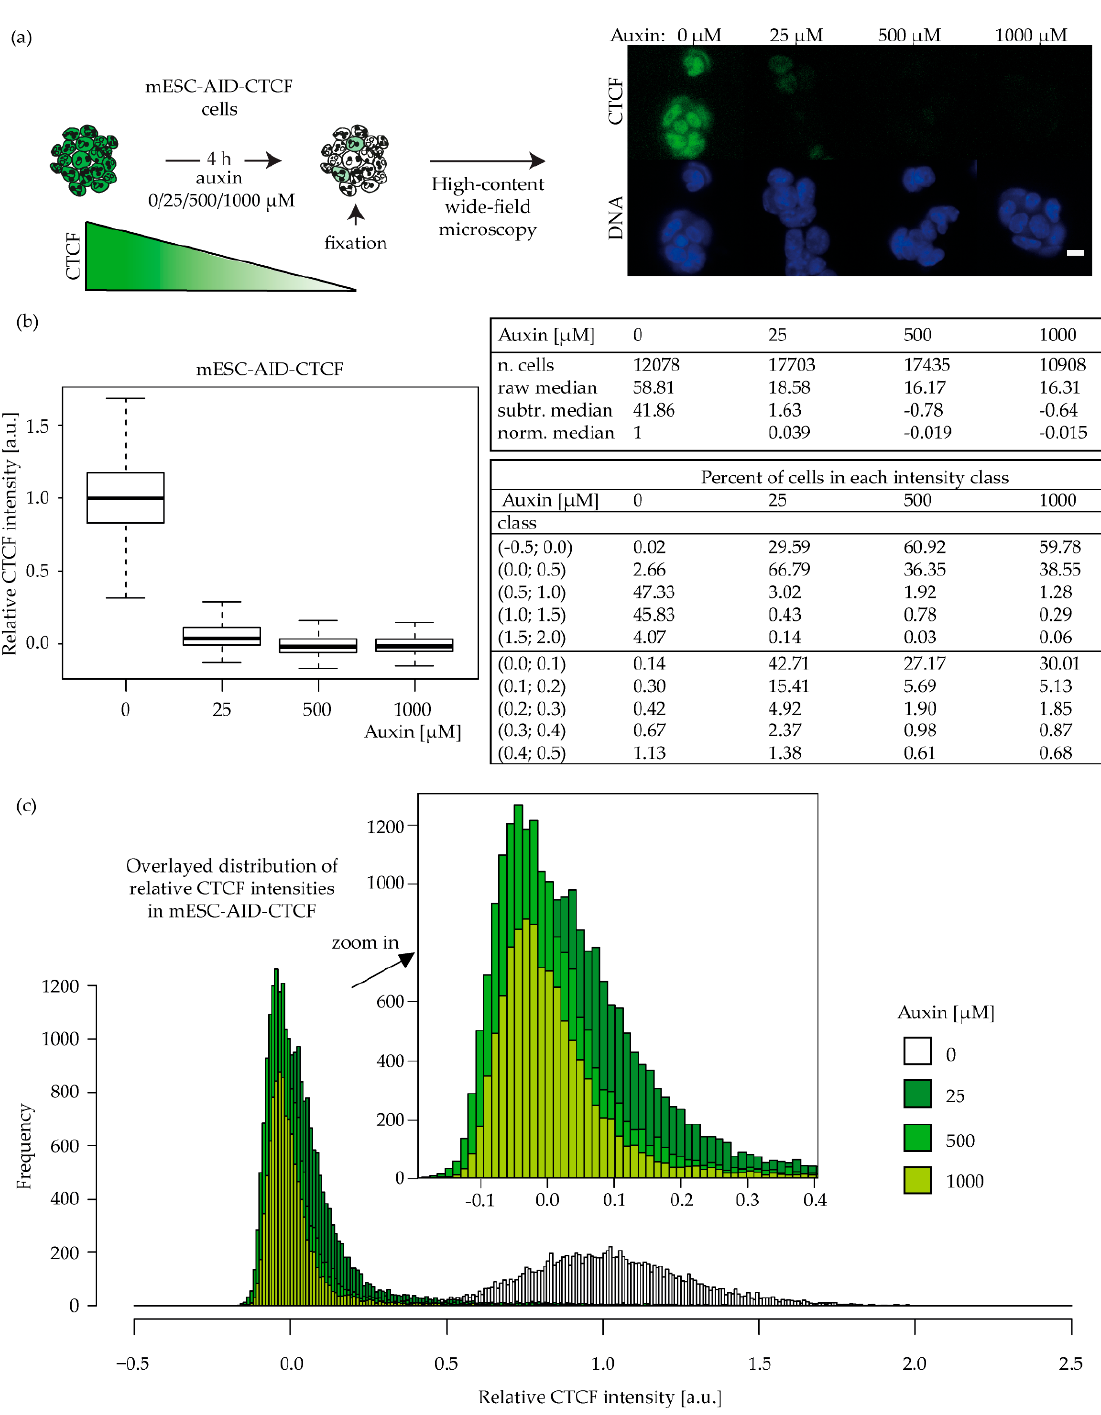
CTCF levels (Figure 8b, see Table S6 for survival data statistics and Figure S4 for colony formation images).